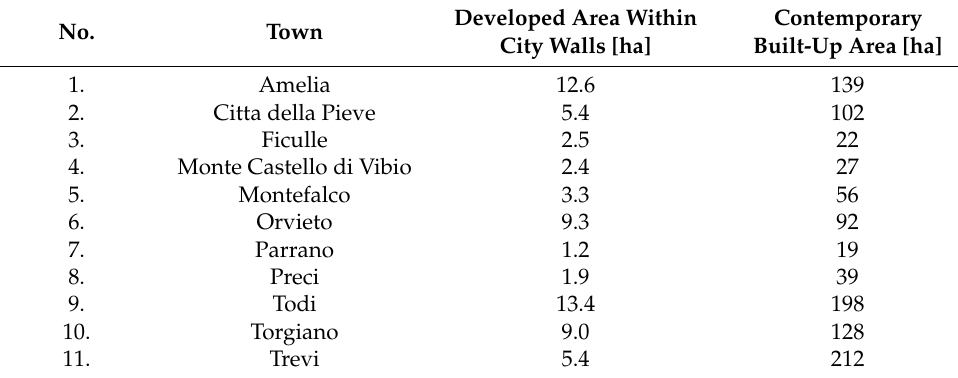
Table 11. Umbrian towns—developed area.